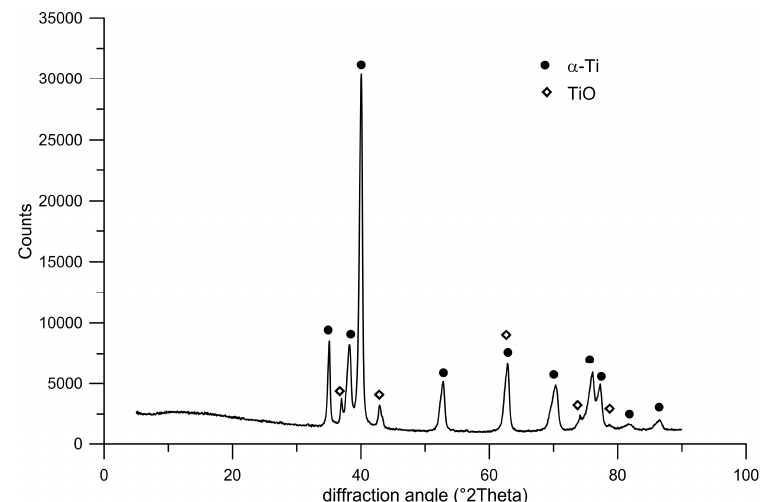
Figure 5. Diffraction pattern showing phase composition of the Ti prepared by plasma spray .